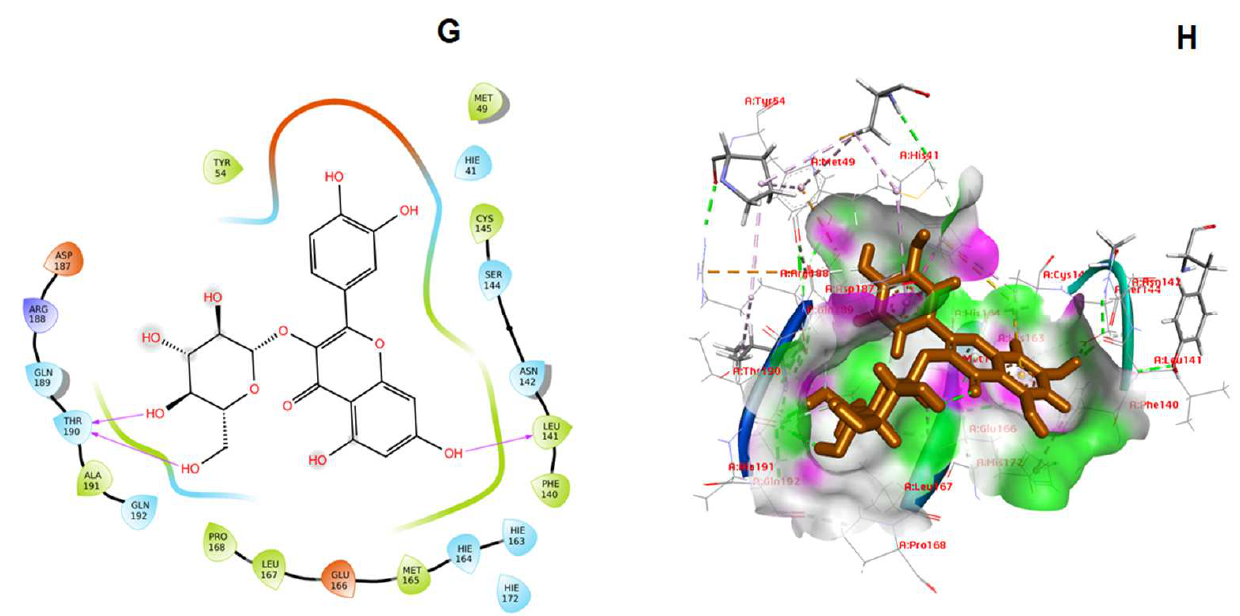
Figure 5. ( G , H ) Illustrations of the interaction between Isoquercitrin and the target M pro protein of SARS-CoV-2.